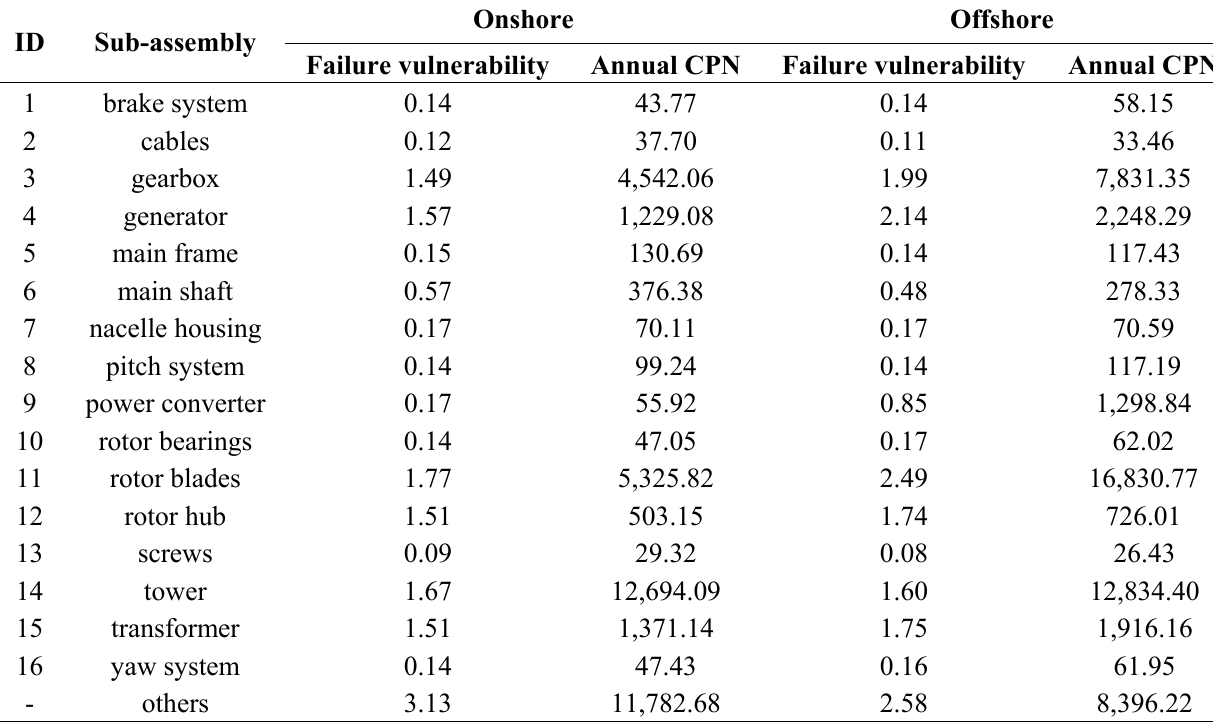
Table 9. Annual CPNs for the sixteen sub-assemblies of onshore/offshore wind turbine